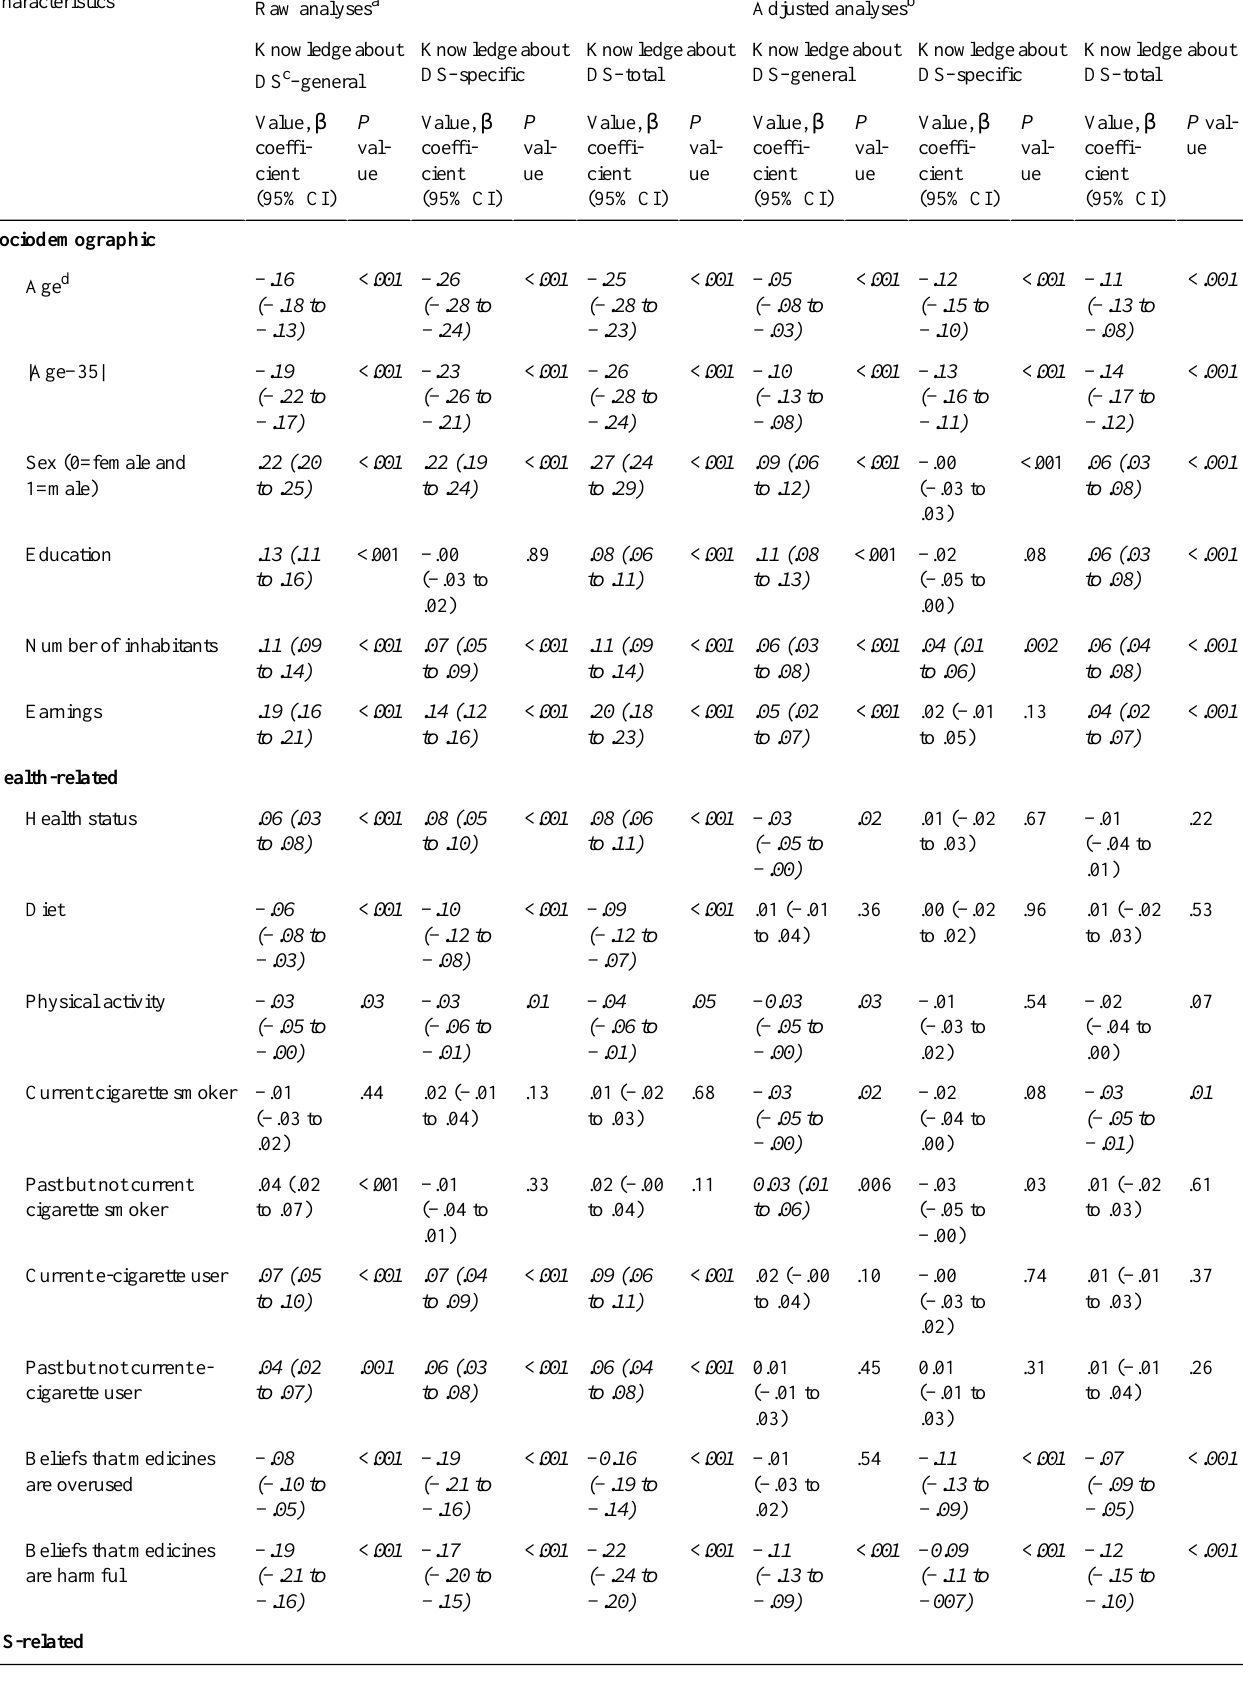
Table 3. Association between characteristics of the study participants and their knowledge about dietary supplements. Analyses were performed in the total sample of 6273 internet users. The results presented in italics are statistically significant at the Benjamini-Hochberg-corrected significance level of